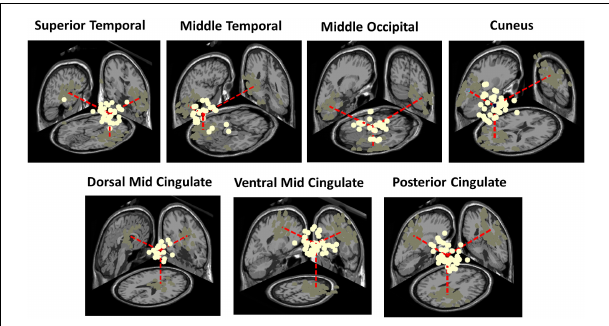
FIGURE 6 | Three-dimensional equivalent dipole model locations of ICs contributing to the adult clusters having most similar centroid locations to the bilateral clusters identified in the infant group. Dipole projections are shown in the sagittal, coronal, and transverse planes of the MNI template brain. Cluster dipole centroids are shown in